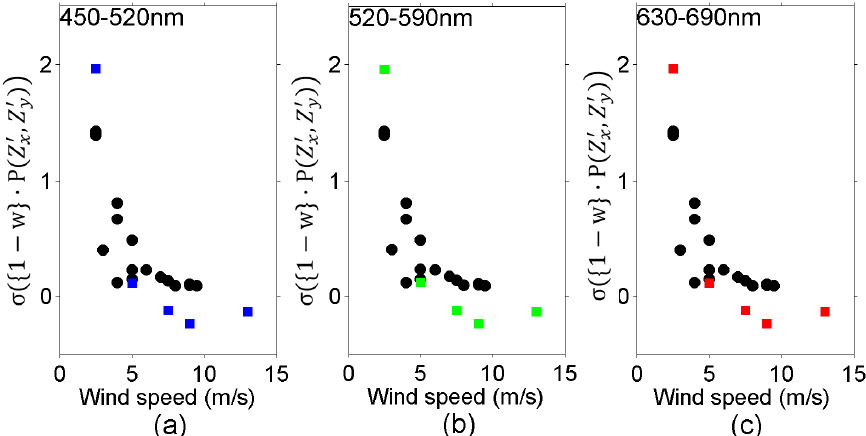
(cid:0) (cid:1) Figure 9. (cid:4668)1 − (cid:1849)(cid:4669) ∙ (cid:1842)(cid:3435)(cid:1852) (cid:3051)(cid:4593) ,(cid:1852) (cid:3052)(cid:4593) (cid:3439) variations with a wind speed that changed ±2 m/s in the 22 samples: ( a ) Figure 9. (cid:4668)1 − (cid:1849)(cid:4669) ∙ (cid:1842)(cid:3435)(cid:1852) (cid:3051)(cid:4593) ,(cid:1852) (cid:3052)(cid:4593) (cid:3439) variations with a wind speed that changed ±2 m/s in the 22 samples: ( a ) Z (cid:48) x , Z (cid:48) y Figure 9. { 1 − W }· P variations with a wind speed that changed ± 2 m/s in the 22 samples: 450–520 nm, ( b ) 520–590 nm, and ( c ) 630–690 nm (colored squares represent samples with solar zenith 450–520 nm, ( b ) 520–590 nm, and ( c ) 630–690 nm (colored squares represent samples with solar zenith ( a ) 450–520 nm, ( b ) 520–590 nm, and ( c ) 630–690 nm (colored squares represent samples with solar angles between 19 and 22°). angles between 19 and 22°). zenith angles between 19 and 22 ◦